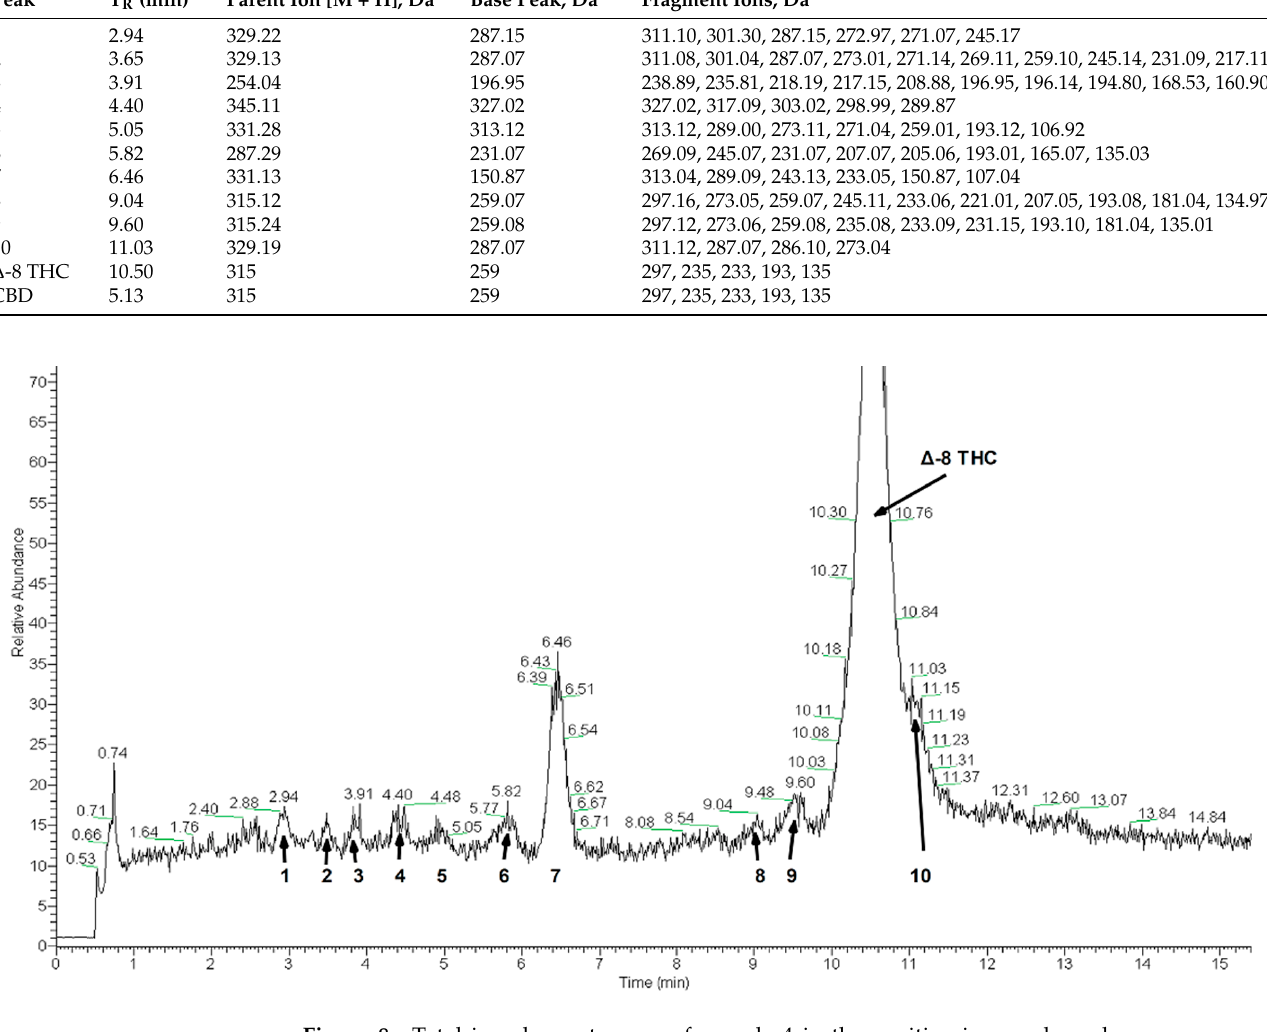
Figure 8. Total ion chromatogram of sample 4 in the positive ion mode and a mass range of m/z = 317 to 750. The peak labels correspond to the peaks listed in Table 2. Table 3. Summary of peaks observed in positive mode total ion